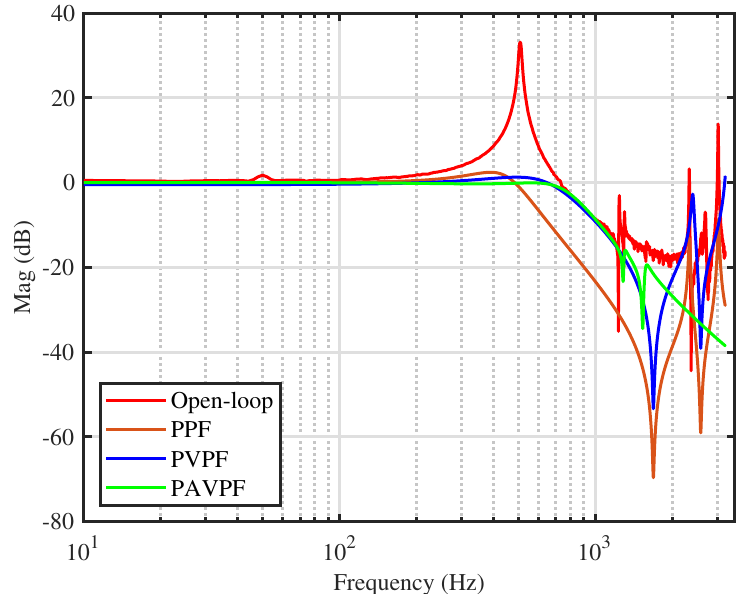
Figure 2. The comparison of magnitude responses of the systems in open-loop and closed-loop under the proposed PPF, PVPF and PAVPF controllers using Eigenvector